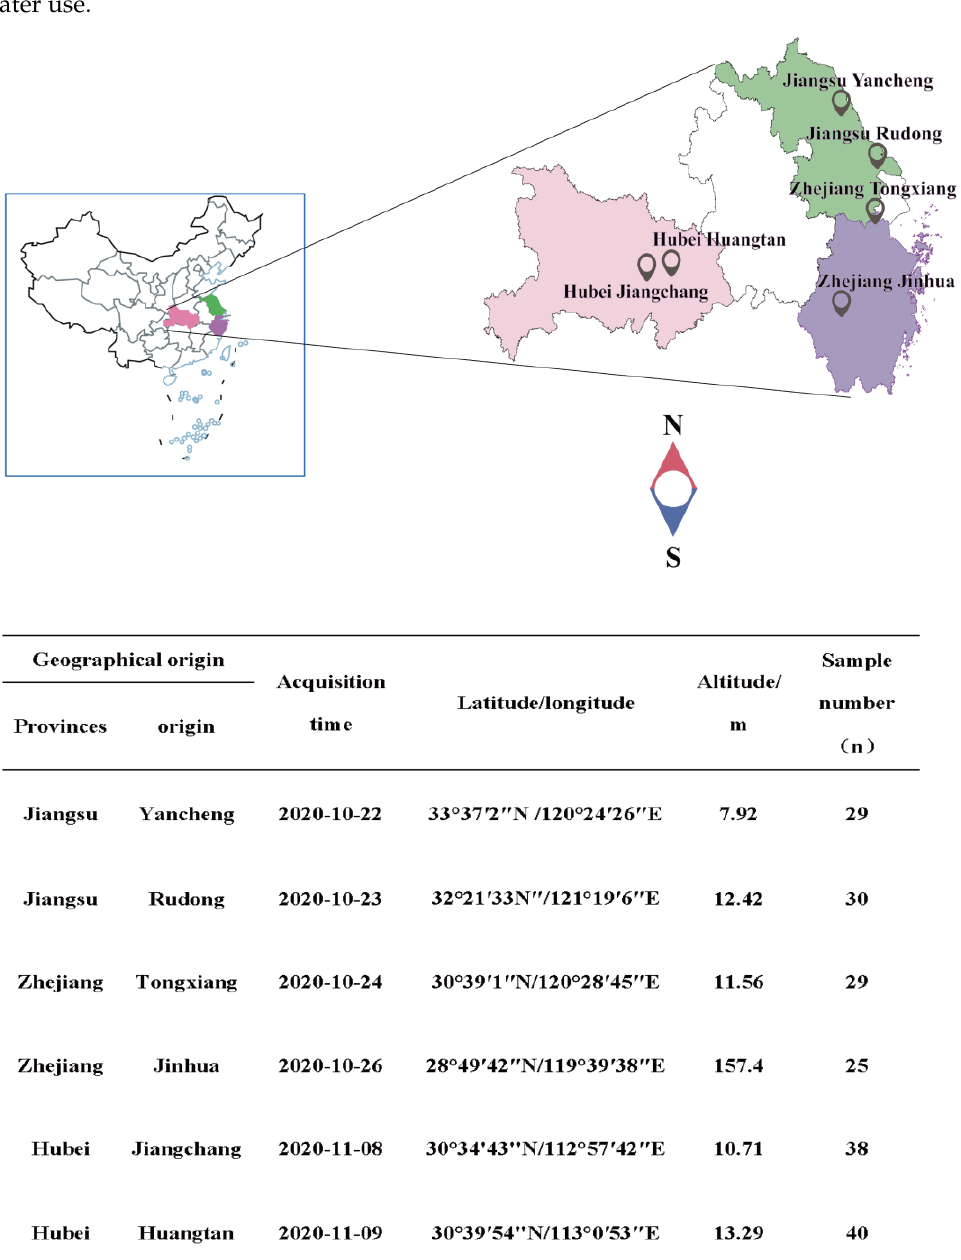
Figure 1. Sampling